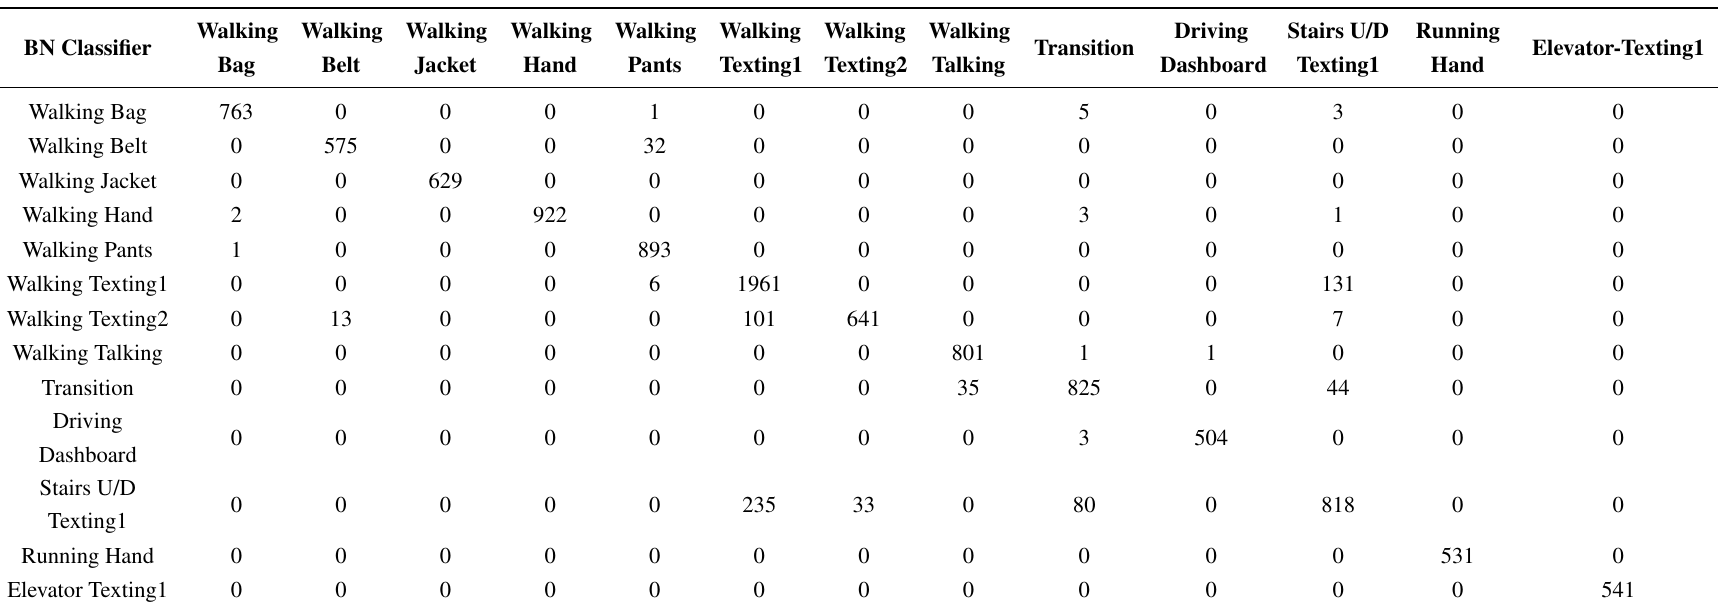
Figure 12. Recognition accuracy using different classifier for different activity modes using four essential features selected by the SVM method. Table 8. Confusion matrix for 12 classes of activity and device location for BN classifier.